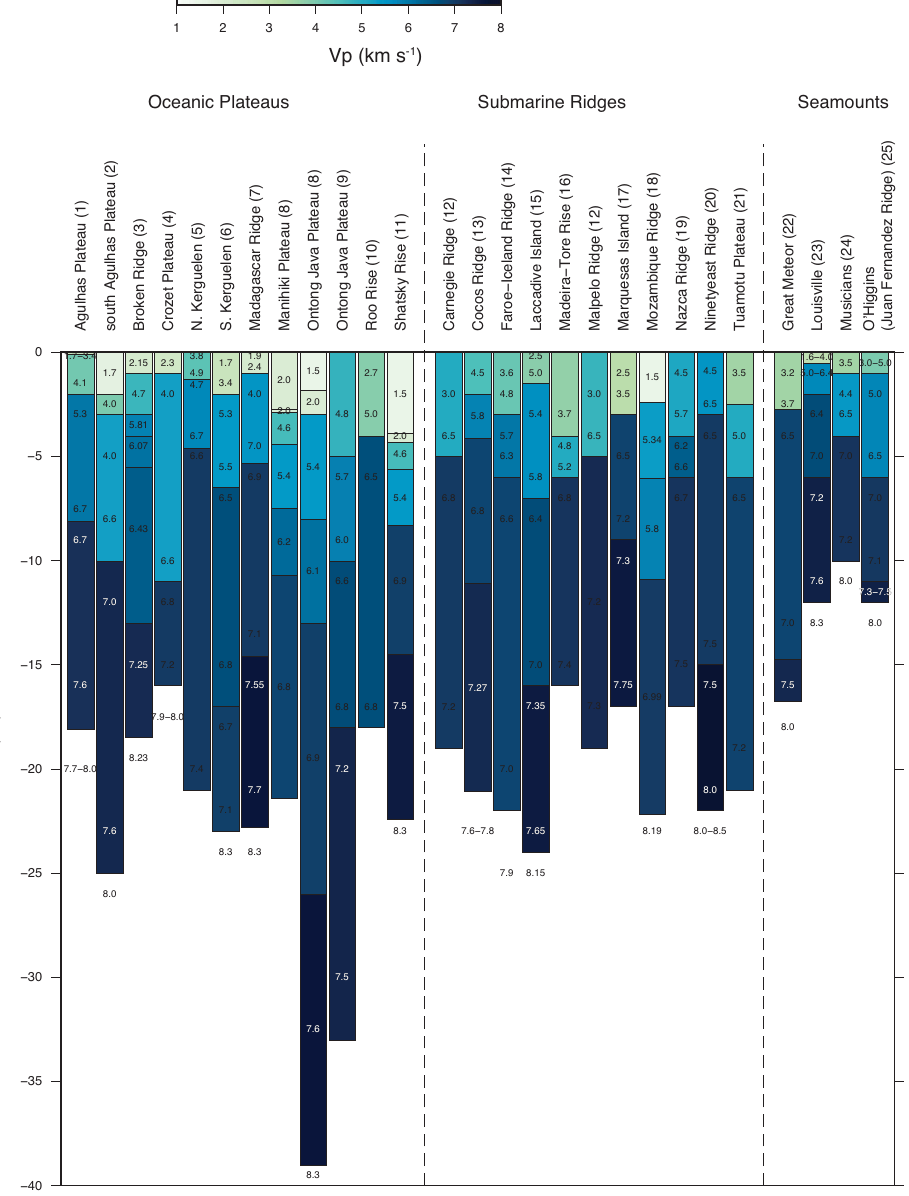
Figure 6. Crustal structures of modern oceanic plateaus and submarine ridges from seismic imaging studies. References are (1) Parsiegla et al. (2008), (2) Gohl and Uenzelmann-Neben (2001), (3) Francis and Raitt (1967), (4) Recq et al. (1998), (5) Charvis and Operto (1999), (6) Operto and Charvis (1995), (7) Sinha et al. (1981), (8) Hussong et al. (1979), (9) Miura et al. (2004b), (10) Shulgin et al. (2011), (11) Den et al. (1969), (12) Sallares et al. (2003), (13) Walther (2003), (14) Bohnhoff and Makris (2004), (15) Gupta et al. (2010), (16) Peirce and Barton (1991), (17) Caress et al. (1995), (18) Hales and Nation (1973), (19) Hampel et al. (2004), (20) Grevemeyer et al. (2000), (21) Patriat et al. (2002), (22) Weigel and Grevemeyer (1999), (23) Contreras-Reyes et al. (2010), (24) Kopp et al. (2003), and (25) Kopp et al.